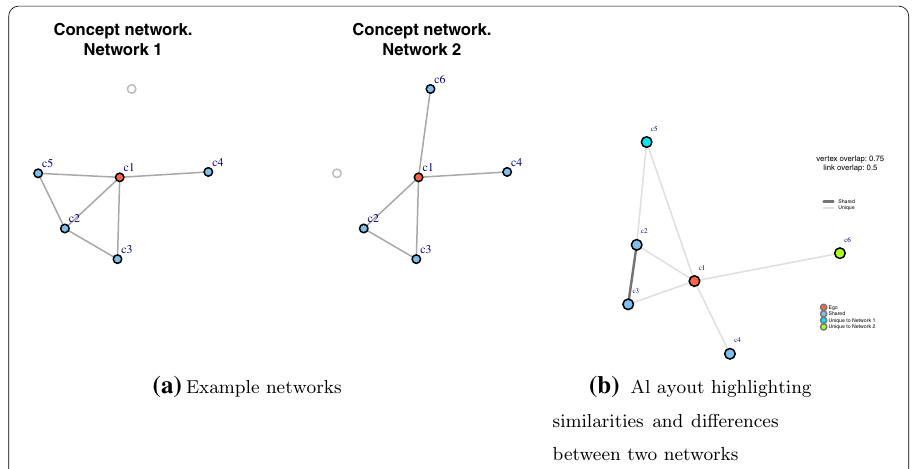
Fig. 1 Semantic networks of actors a and a ′ centered around concept c 1. Both networks share concepts c 2, c 3 and c 4 (excluding c 1), which makes for a vertex overlap index of 3/4 as the minimum vertex size is 4. The link overlap index is 1/2, as one alter-alter link is shared (between c 2 and c 3) and the minimum link set size